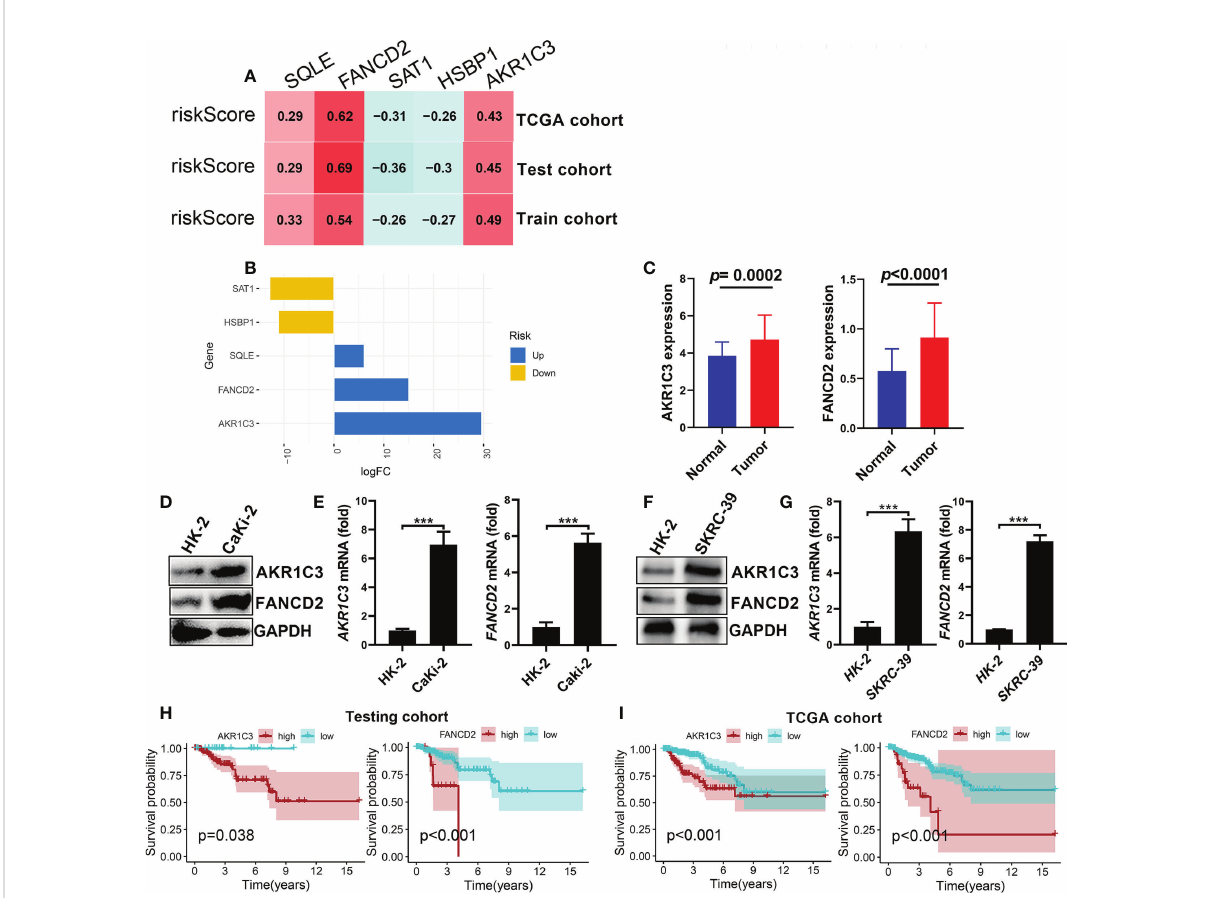
FIGURE 8 Identi fi cation and validation of the high-risk genes considered for FRGPI (A) Correlation analysis between the expression levels of the fi ve genes and risk score (FRGPI score) in KIRP. (B) Variance multiple analysis of fi ve cores FRGs in the distinct FRGPI subgroups (risk hi and risk lo groups) from the TCGA dataset. (C) Comparison of AKR1C3 and PANCD2 expression levels between KIRP and normal tissues. (D, E) The mRNA and protein expression levels of AKR1C3 and PANCD2 in human Caki-2 cells detected by q-pcR and western blotting (***p < 0.001) . (F, G) The mRNA and protein expression levels of AKR1C3 and PANCD2 in human SKRC-39 cells detected by q-pcR and western blotting (***p < 0.001). (H, I) Kaplan – Meier survival curves associated with AKR1C3 and PANCD2 in the testing and TCGA